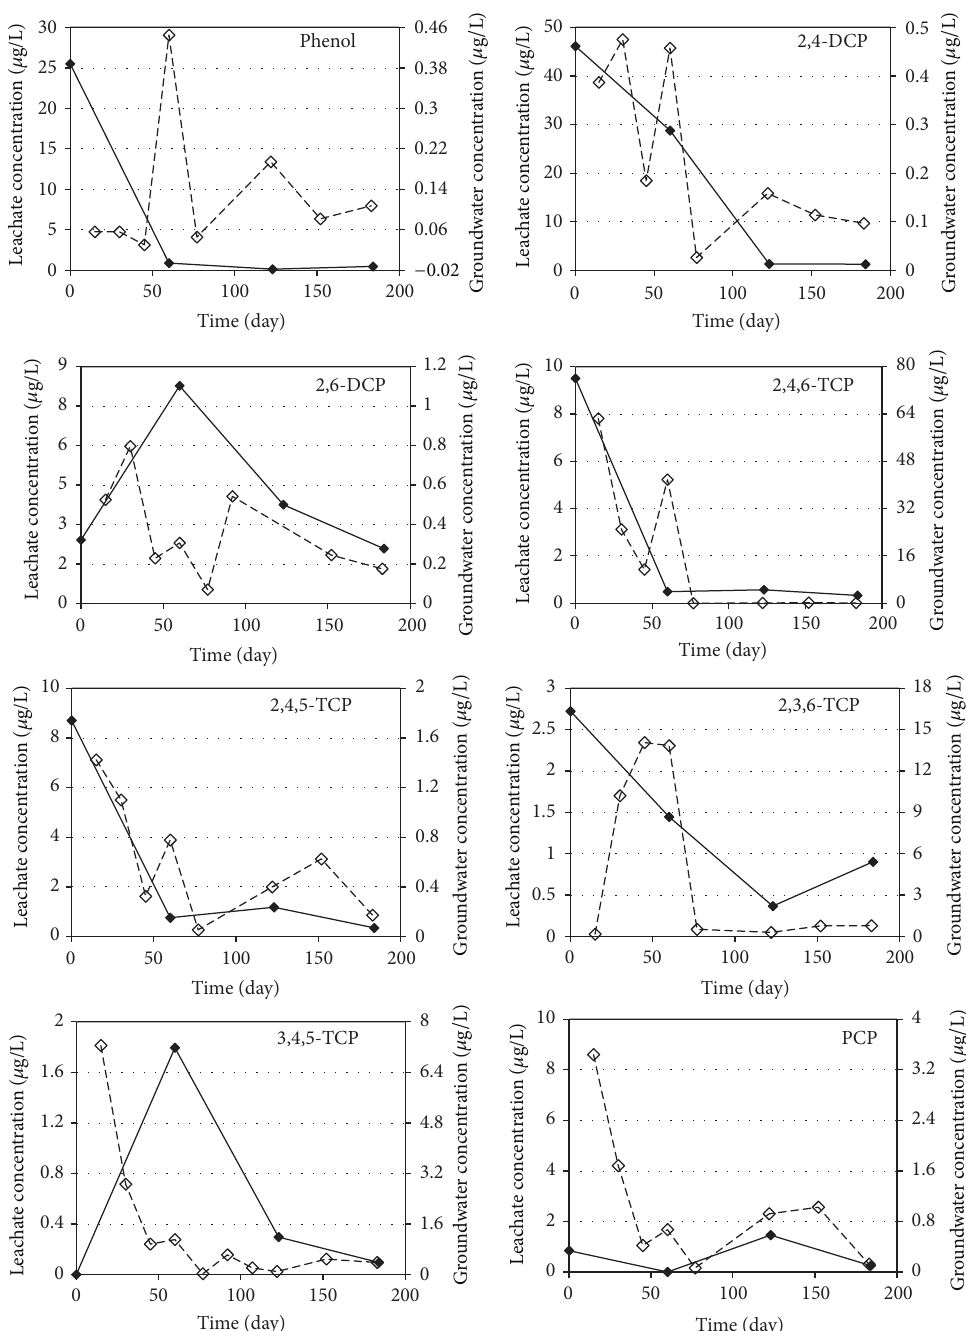
Figure 5: Variations of the phenolic compounds in groundwater and leachate samples of R4 reactor (——: leachate concentration, -----: groundwater